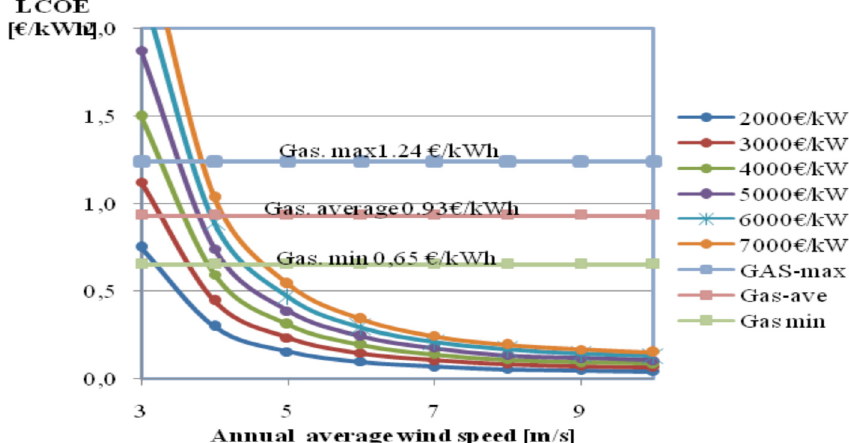
Fig. 6. LCOE for wind versus gasoline generators in